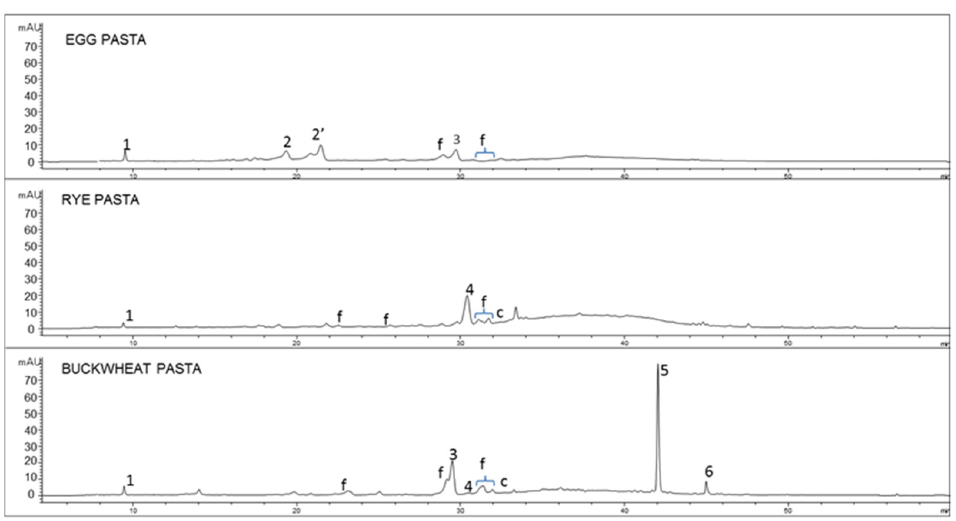
Figure 1. Chromatographic profile (Relative abundance as y axis vs. Retention time as x axis) acquired by HPLC-DAD (350 nm) of the hydroalcholic extracts of cooked buckwheat pasta, rye pasta, egg pasta. Identified compounds: 1 = indoleacetic acid derivative, 2,2 ′ = apigenin diglicosides, 3 = rutin, 4 = ferulic acid, 5 = quercetin, 6 = kaempferol, f = flavonoids. Table 1. Caffeic derivatives (caffeic der), flavonoids and indoleacetic acid derivative (IAA der) content in cooked pasta samples. Data are the mean of three determinations (standard deviation < 5%). The percentage of single classes of identified compounds is shown in brackets.